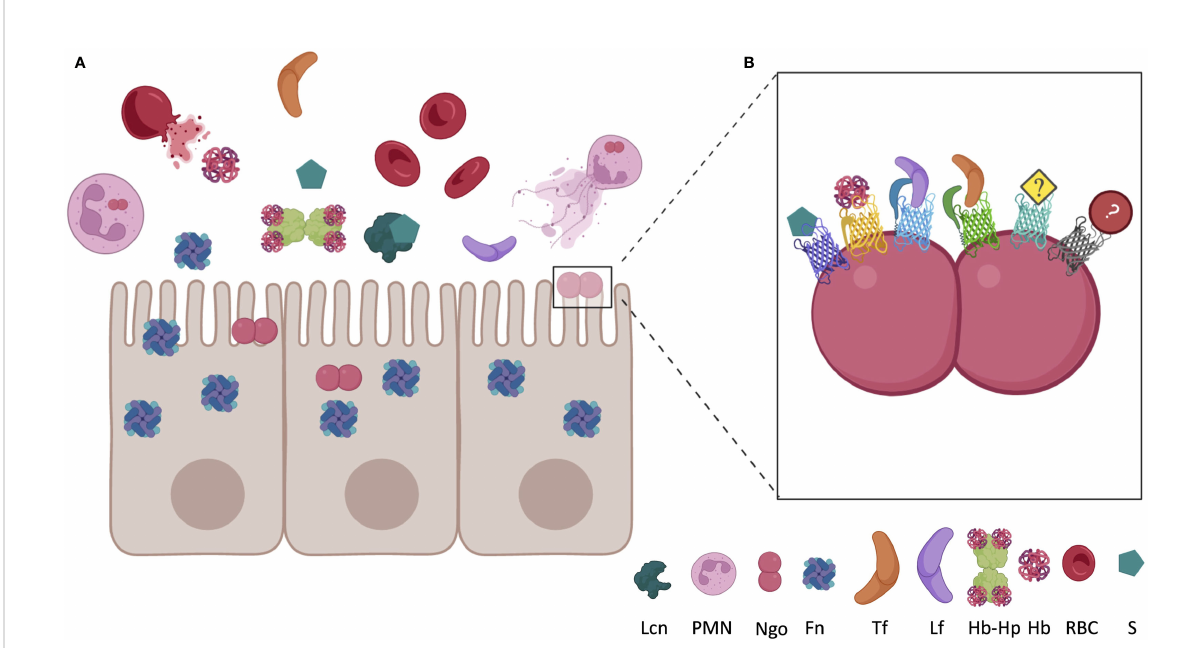
FIGURE 1 Localization of host nutritional immunity proteins near epithelial cell surface during in fl ammation and Neisseria gonorrhoeae (Ngo) infection. (A) In a healthy environment, iron is almost entirely bound to intracellular ferritin (Fn), erythrocyte bound haptoglobin, or sequestered in circulating transferrin (Tf). Under in fl ammatory conditions, Fn may be released from epithelial cells and hemoglobin (Hb) may be released from red blood cells (RBC). Haptoglobin (Hp) almost immediately binds to the newly circulating Hb, forming the Hb-Hp complex. Infection by Ngo recruits PMNs, which can expel their cellular contents in an innate immune response, which includes lactoferrin (Lf). Coinfection with other bacteria, or presence of commensals, may lead to circulation of siderophores (S). Siderophores produced by bacteria, or the mammalian siderophore 2,5-DHBA, may also be present at the site of infection bound to circulating lipocalin (Lcn). (B) Ngo has evolved mechanisms to cope with the nutritional immunity evoked by the host. TonB- dependent proteins bind many of the host Fe-chelating proteins, permitting Ngo to grow in these metal-restricted environments. FetA binds to S, HpuAB bind to Hb or Hb-Hp, TbpA binds to Tf, LbpA binds to Lf, and TdfF and TdfG are both iron regulated, but the host ligand has yet to be identi fi ed. Utilization of iron from ferritin and lipocalin should be investigated due to the close proximity to Ngo during infection. Figure not to scale and generated with